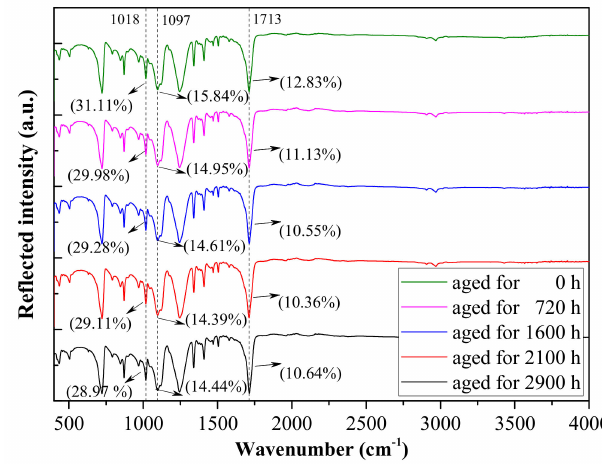
Figure 1. Fourier transform infrared (FTIR) spectra of thermally aged PET films aged at 110 ◦ C.